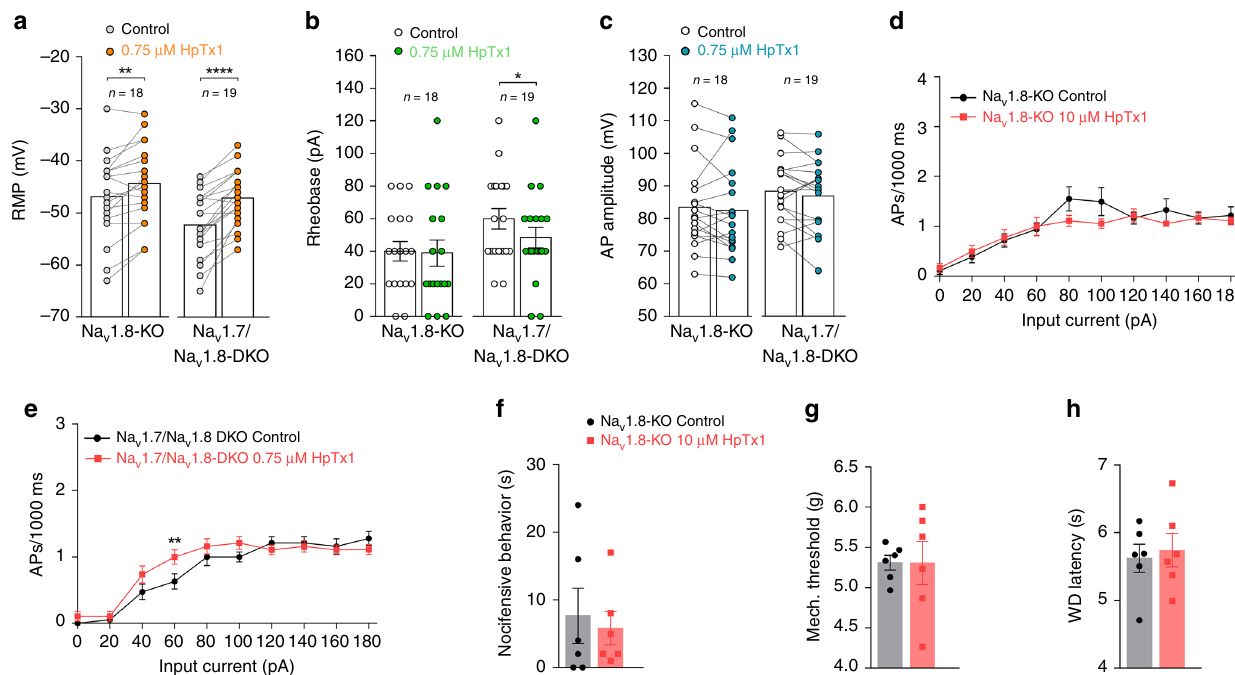
Fig. 5 HpTx1 has no effect on pain responses in Na v 1.8-KO mice. a – e Current-clamp recordings show the effects of HpTx1 on the excitability of small DRG neurons from Na v 1.8-KO mice and Na v 1.7/Na v 1.8-DKO mice. a RMP (two-way repeated measures ANOVA followed by Bonferroni ’ s multiple